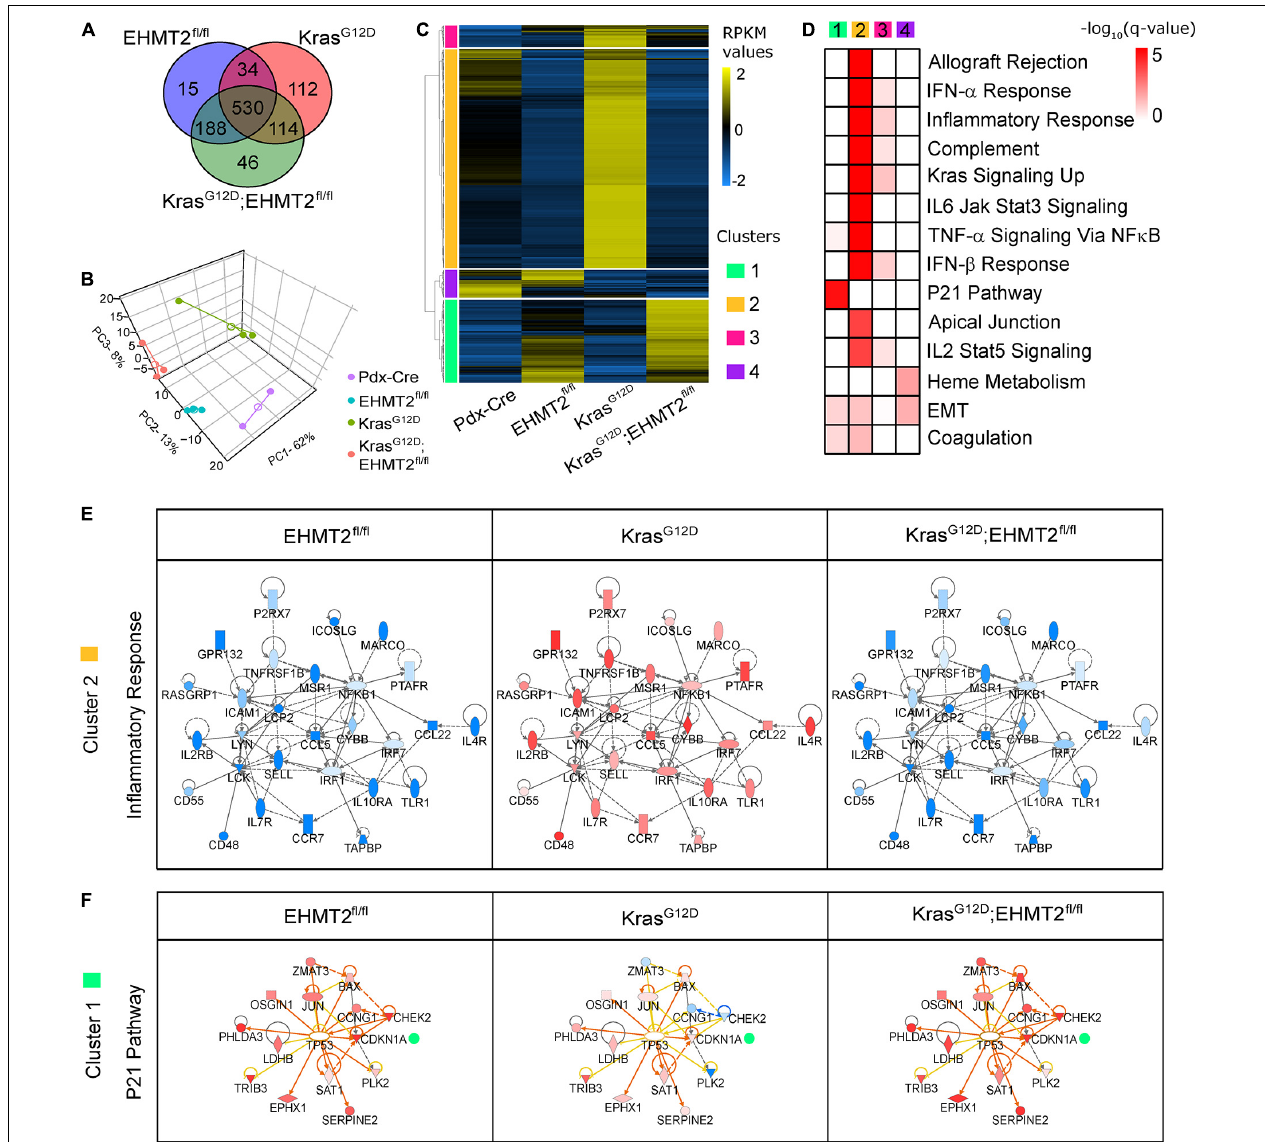
FIGURE 5 | RNA-seq analysis of conditional knockout of EHMT2 in Kras G 12 D -expressing animals reveals an antagonistic transcriptional response. (A) Venn diagram of differentially expressed genes (DEGs) from Pdx1-Cre;EHMT2 fl / fl ( n = 3), Pdx1-Cre;LSL-Kras G 12 D ;EHMT2 + / + ( n = 3), and Pdx1-Cre;LSL-Kras G 12 D ;EHMT2 fl / fl ( n = 3) mice relative to Pdx1-Cre control animals ( n = 2) by RNA-seq. (B) PCA plot comparing genotype groups with centroids (open circles) and individual animals (filled circles) using RPKM expression values of DEGs. (C) Heatmap depicts RPKM expression levels of DEGs normalized to the z-scale. Hierarchical clustering representing four major expression patterns is labeled on the left of the heatmap (green, Cluster 1; orange, Cluster 2; pink, Cluster 3; and purple, Cluster 4). Average of normalized RPKM values is represented in yellow (up), blue (down), and black (no change). (D) Pathway enrichment analysis of gene clusters in panel (C) . Color scale denotes –log 10 ( q -value) for significance of each represented pathway. (E) The inflammatory gene network enriched in Cluster 2, which represents genes upregulated by Kras G 12 D activation but downregulated in animals carrying the EHMT2 fl / fl allele. Gene fold changes with respect to controls are represented with red (up) and blue (down) nodes. (F) Upstream regulatory analysis of genes in Cluster 1, which represent the P21 pathway upregulated in EHMT2 fl / fl mice. Color scheme of nodes is same as in panel (E) . Outlined central node represents the predicted link with the upstream regulator, TP53, while orange lines and blue lines indicate predicted relationships that lead to activation or inhibition, respectively. Yellow lines designate that the predicted relationship is inconsistent with gene expression, and gray lines denote no predicted effect.